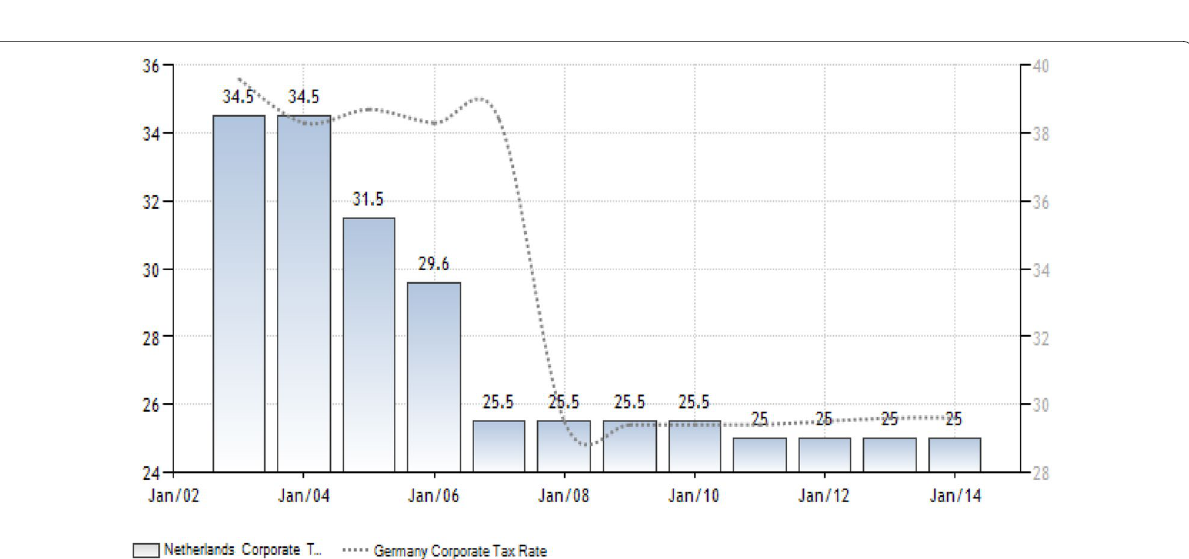
Fig. 3 The Netherlands and German corporate tax